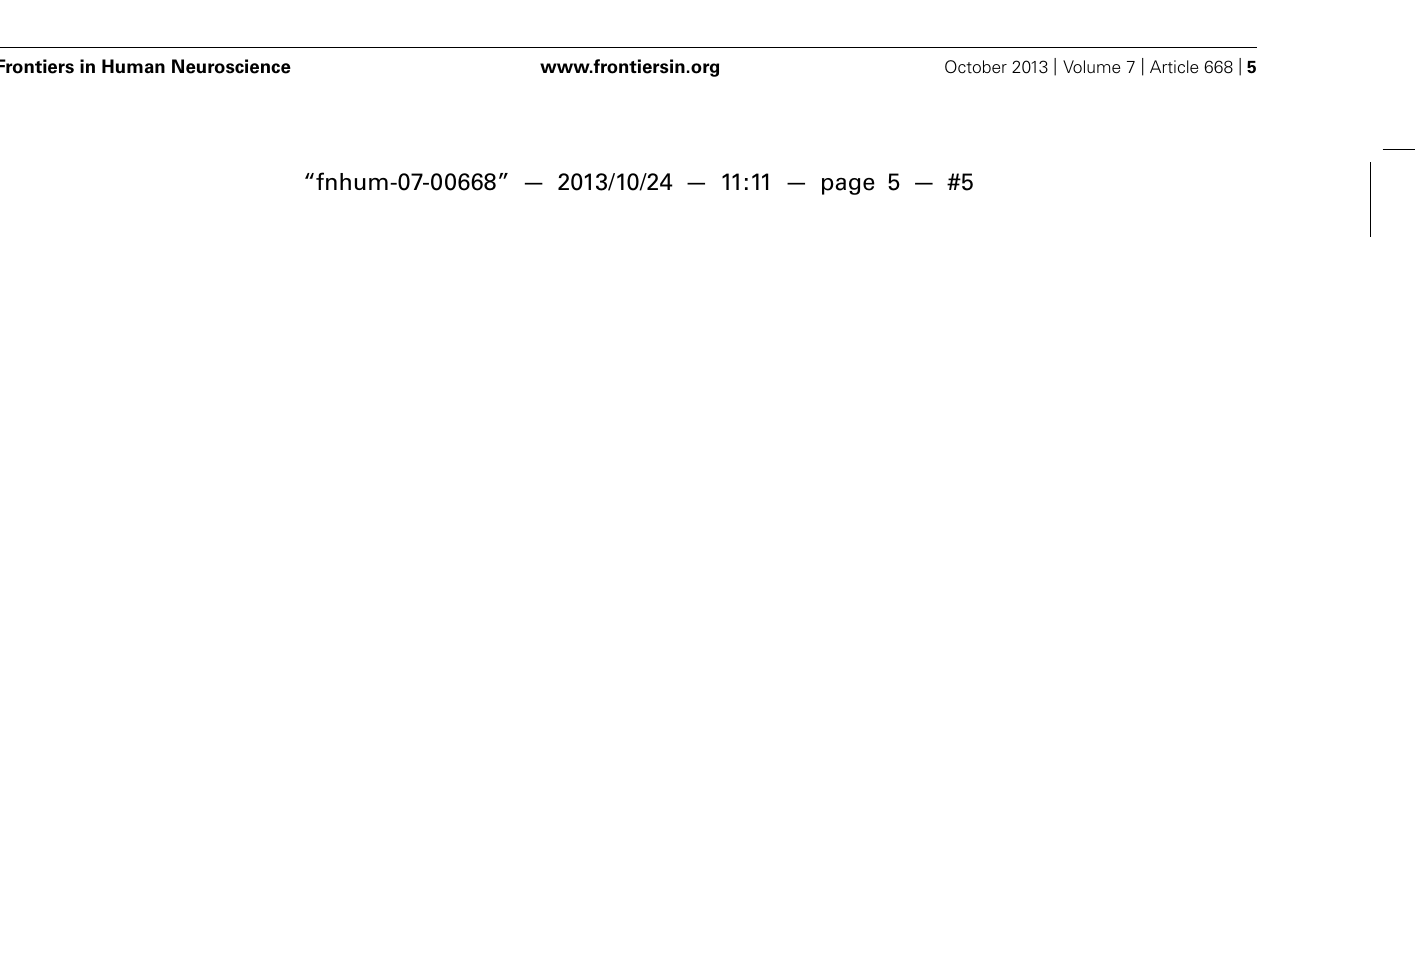
whether participants would implicitly learn about this underlying stimulus distribution and how this would influence their performances. (B) Participants quickly exhibited attractive estimation biases: they tended to perceive motion direction as being more similar to the most frequent directions, − 32 ◦ and 32 ◦ (vertical dashed lines), than they really were. (C) On trials when there was no stimulus but participants reported seeing a stimulus (blue line), they tended to report directions close to − 32 ◦ and 32 ◦ (vertical dashed lines). When they correctly reported that there was no stimulus (red line), their estimation was more